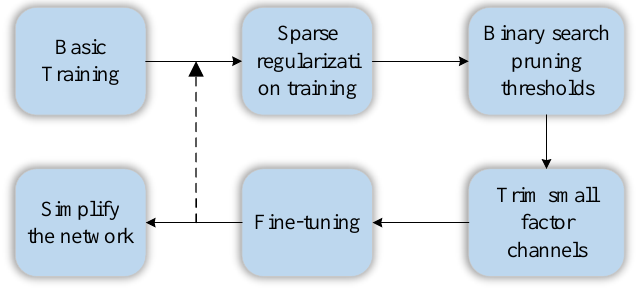
Figure 2. Strategy of dynamic threshold pruning.